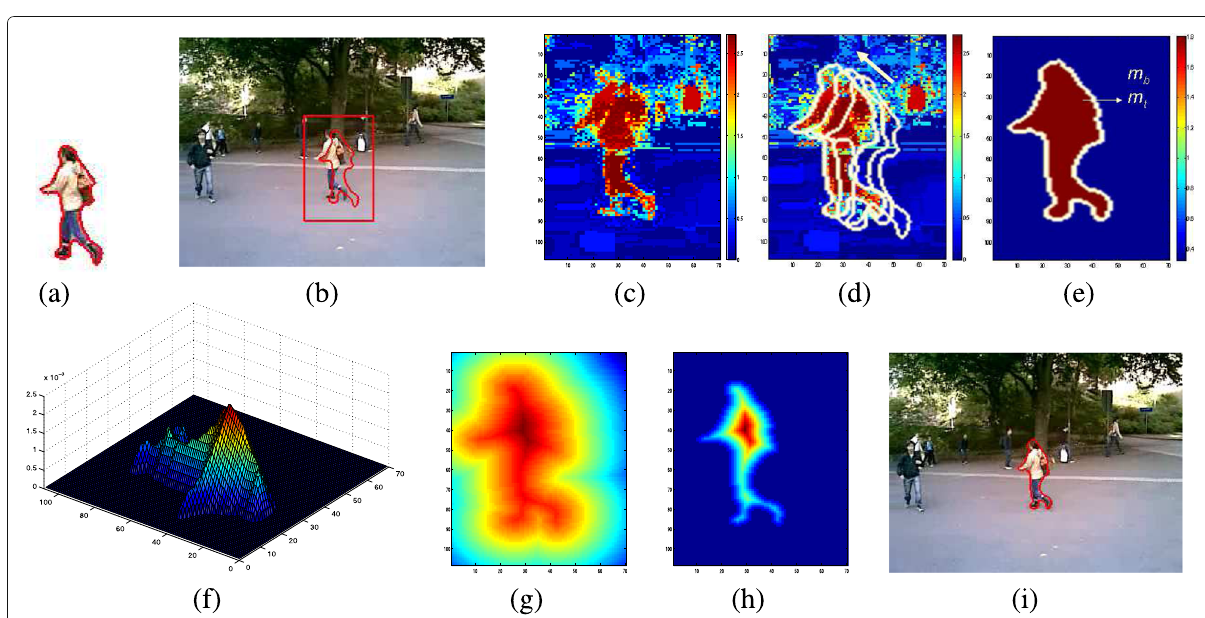
Fig. 3 Tracking mechanism of the proposed method. Employing pedestrian sequence as an example, a and b show the initial curve obtained from previous frame where we admit 15 pixels extension for the new kernel adaptation. c The corresponding candidate samples weights. Then, we include the active contour model into this sample space ( d ) to separate them into two classes (foreground/background) and obtain the adaptive kernel that maximizes the appearance similarity ( e ). g The level set function of the contour and f , h the corresponding kernel which is used within the mean shift framework for deforming object tracking tasks ( i )